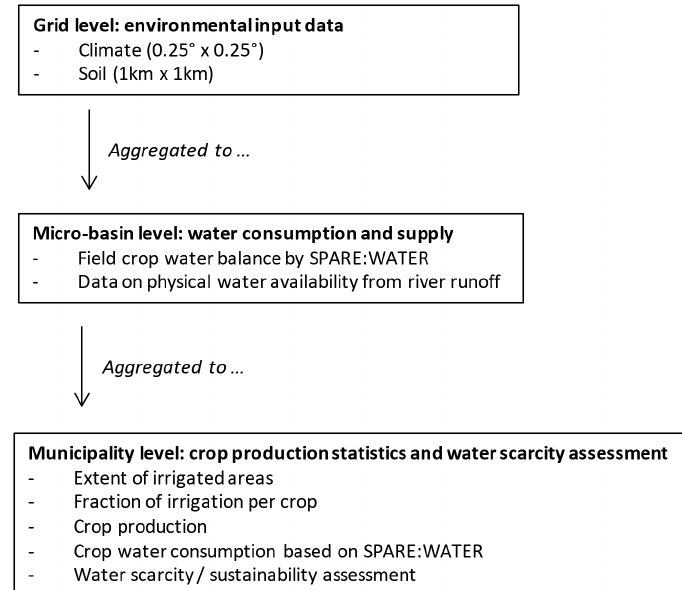
Figure A1. Spatial aggregation steps in the